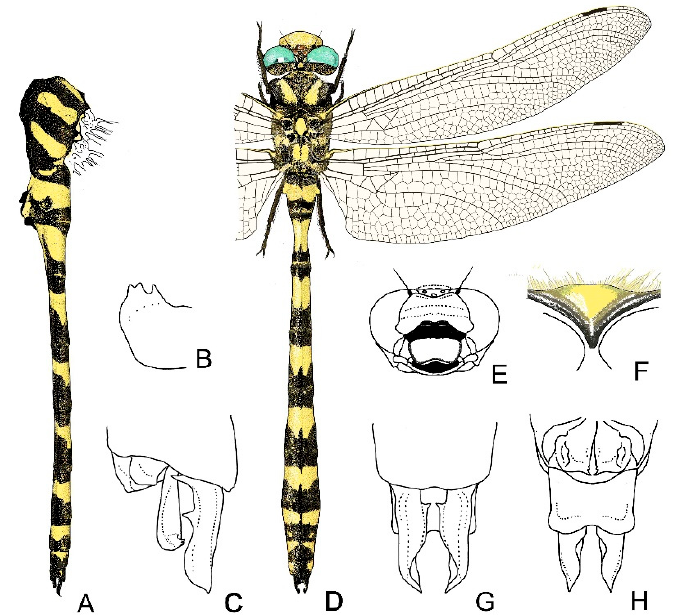
Figure 15. Cordulegaster cilicia sp. nov., holotype , (RMNH, leg. Gert Jan van Pelt, RMNH.INS.974914, ♂ 9 July 2008, Turkey, Kahramanmara¸s, Göksun, 38.0614 ◦ N, 36.4722 ◦ E, 1350 m a.s.l.): ( A ): habitus, lat- eral. ( B ): detailed latero-dorsal view on the hook of the inferior appendix. ( C ): appendages, lat- eral. ( D ): habitus, dorsal. ( E ): head, schematically. ( F ): occipital triangle, frontal. ( G ): appendages, dor- sal. ( H ): appendages, ventral. Thorax (Figure 15A,D): anterior lobe of the pronotum with yellow front edge; median lobe black with yellow dorsolateral wing-shaped patterns; posterior lobe yellow interrupted by middorsal black band; front of synthorax with broad big yellow antehumeral stripes, narrowing moderately towards pronotum leaving less than 30% black of the antehumeral region; mesepimeron and metepimeron with broad yellow bands; metepisternum black with tiny yellow markings near base of wings; metakatepisternum black; poststernum black; coxae black with yellow ventral parts, trochanter, femora, tibiae and tarsi black. Wing (Figure 15D) hyaline; costal veins yellow, other veins black; Pt dark brown, Pt FW 4.2 × 0.5, HW 4.5 × 0.7; anal triangle 3-celled; membranula narrow. Abdomen (Figure 15A,D): colour pattern as in Figure 15A,D; S1 dorsal black, yellow marking on side of S1 small, S2–9 with medium sized yellow markings leaving ca. 50% black, on dorsal view of S2–5 there are a pair of small, linear yellow spots present on the dorsal distal part of abdominal segments not touching in middle of the segment, on S2–10 black markings reaching lateral sides, yellow markings present on S9–10. Appendages (Figure 15B,C,G,H): superior appendages in dorsal view broad and